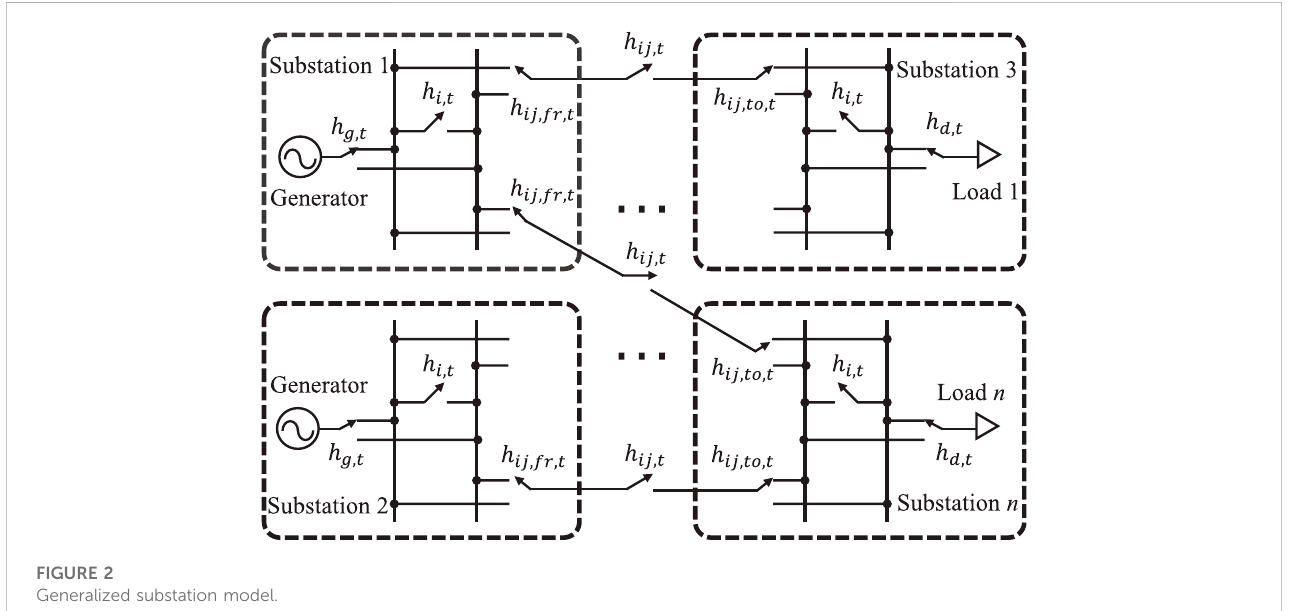
FIGURE 2 Generalized substation model.